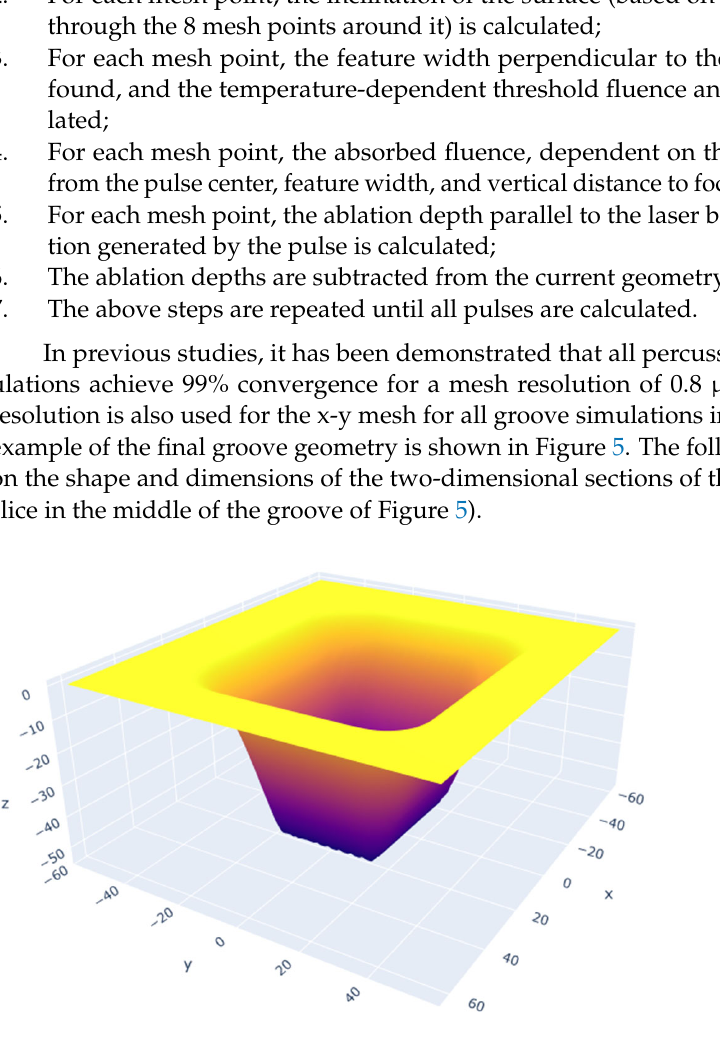
Figure 5. Example of a bidirectional simulation result in three dimensions. All units are in μ m.